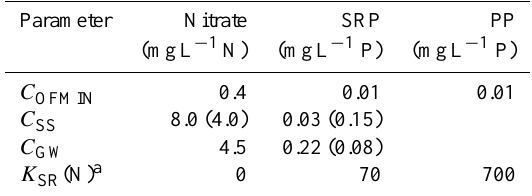
Table 4. Nutrient modelling parameters from the baseline and MI scenarios (only values that were modified from the baseline in the MI scenario are shown in parentheses).